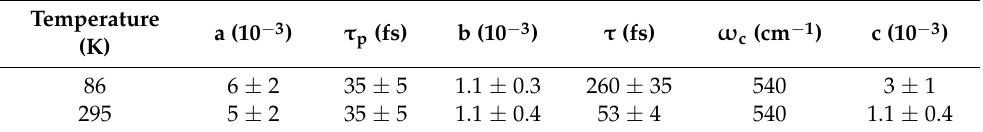
Table 2. Fitting parameters to the CLS at 86 K and 295 K shown in Figure 6c according to the model described by Equation (2), where the parameter ω c is kept